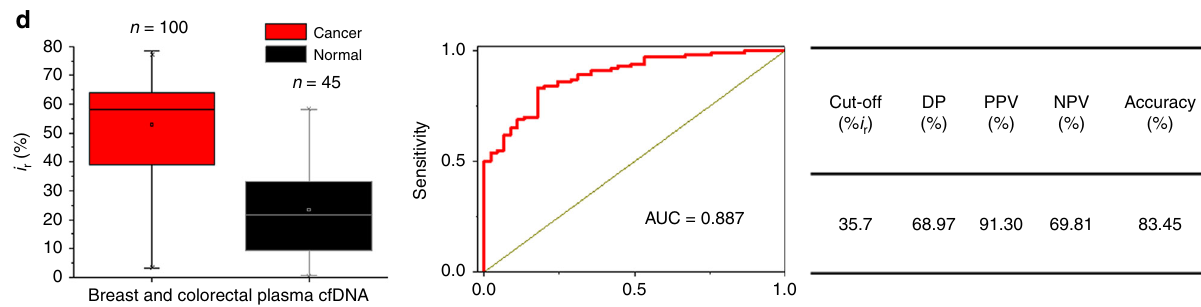
Fig. 3 Practical application of Methylscape approach. a Differential af fi nity/adsorption of genomic DNAs as a function of their cancer and normal origin. Bars represent the relative current (% i r ) mean values for DNA genomes derived from various normal (Black bars: Human Mammalian Epithelial Cell (HMEC), Prostate Epithelial cell (PrEC)) and cancer cell lines (Red bars: Breast cancer: BT474, MCF7, T47D, LNCap prostate cancer, HCT116 colorectal cancer and H-1975 lung cancer). Each data point represents the average of three separate trials, and error bars represent the standard deviation of measurements (%RSD = < 5% for n = 3). Right panel: Corresponding DPV graphs for all cell line DNAs and their respective baseline. b Individual box plot showing mean relative current (% i r ) values generated by electrochemical detection of genomic DNAs extracted from normal and cancer tissues of various cancer types (breast, prostate and lymph node). c The combined data for all the tissue samples derived from 31 healthy individuals and 72 cancer patients, Right: the ROC analysis and diagnostic test evaluation shows the Disease Prevalence (DP), positive predictive values (PPV), negative predictive values (NPV) and accuracy of the method. d Box plot showing relative current (% i r ) mean values generated by electrochemical detection for genomic DNAs extracted from plasma samples derived from 45 healthy individuals and 100 breast cancer patients, Right: the ROC analysis and diagnostic test evaluation shows the Disease Prevalence (DP), positive predictive values (PPV), negative predictive values (NPV) and accuracy of the method. In the box and whisker plots, the middle lines of the boxes represent the median (50th percentile) and the terminal line of the boxes represents the 25th to 75th percentile. The whiskers represent the lowest and the highest